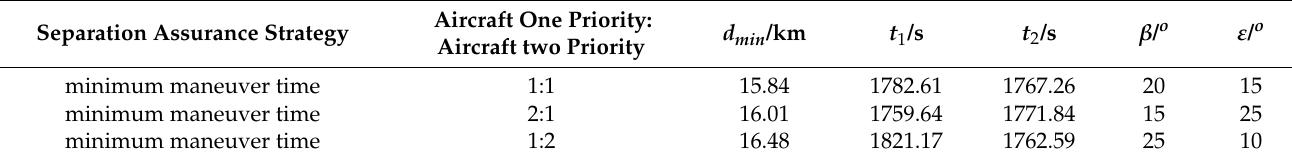
Table 4. Simulation results at different